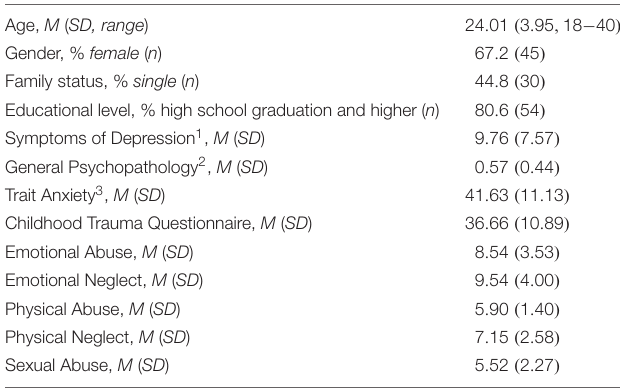
TABLE 1 | Subject characteristics and mean values on the assessments ( N =